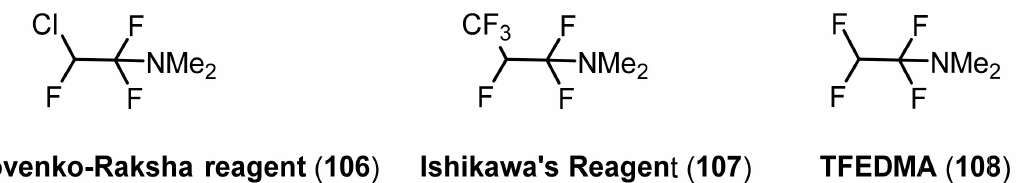
Figure 5. Representative fluoroalkyl amino